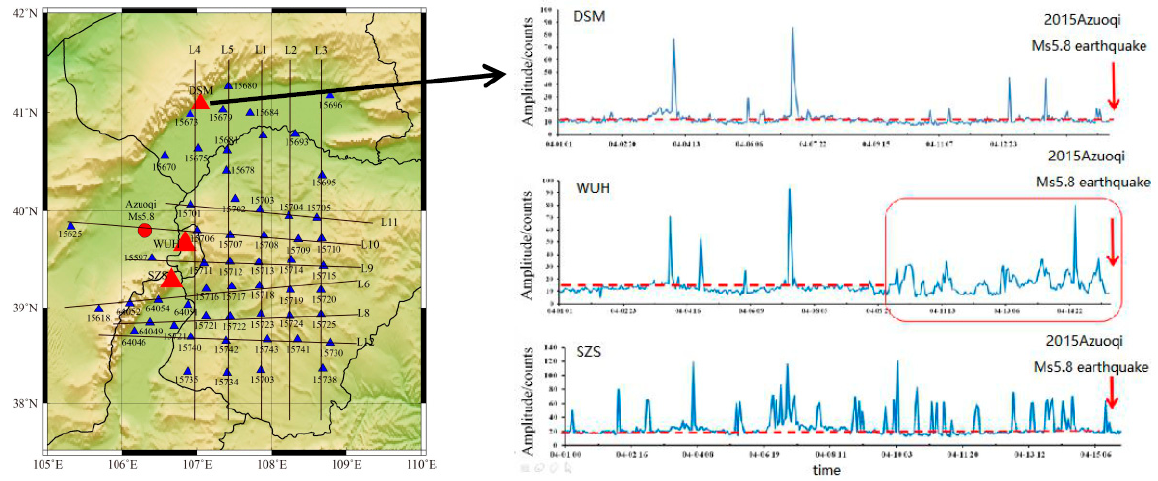
Figure 19. Low-frequency signal characteristics and 15670 in L7 = DSM.